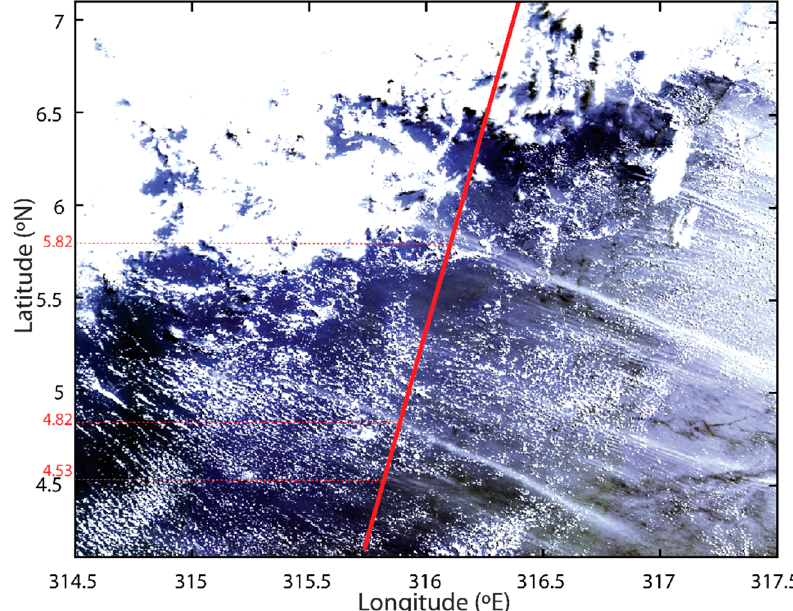
Figure 9. Sentinel-3A OLCI image dated 25 May 2017 from relative orbit 095 of cycle 018 showing large amplitude ISWs. The red line is the altimeter satellite track. Note the coincidence of the OLCI internal wave features, pointed out by the dashed red lines with corresponding latitudes written in the y -axis, with the SRAL detected ISW features in Figure 8.